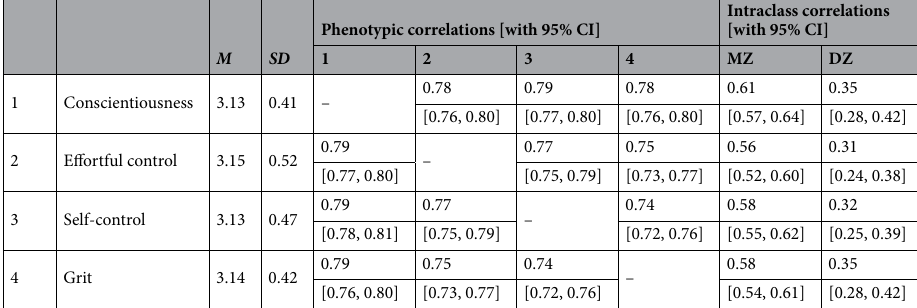
Table 1. Descriptive statistics, and phenotypic and intraclass twin correlations (with 95% confidence intervals) of the four conscientiousness variables. In the phenotypic correlation matrix, numbers below the diagonal are simple correlations, and those above the diagonal partial correlations after controlling for age and sex.